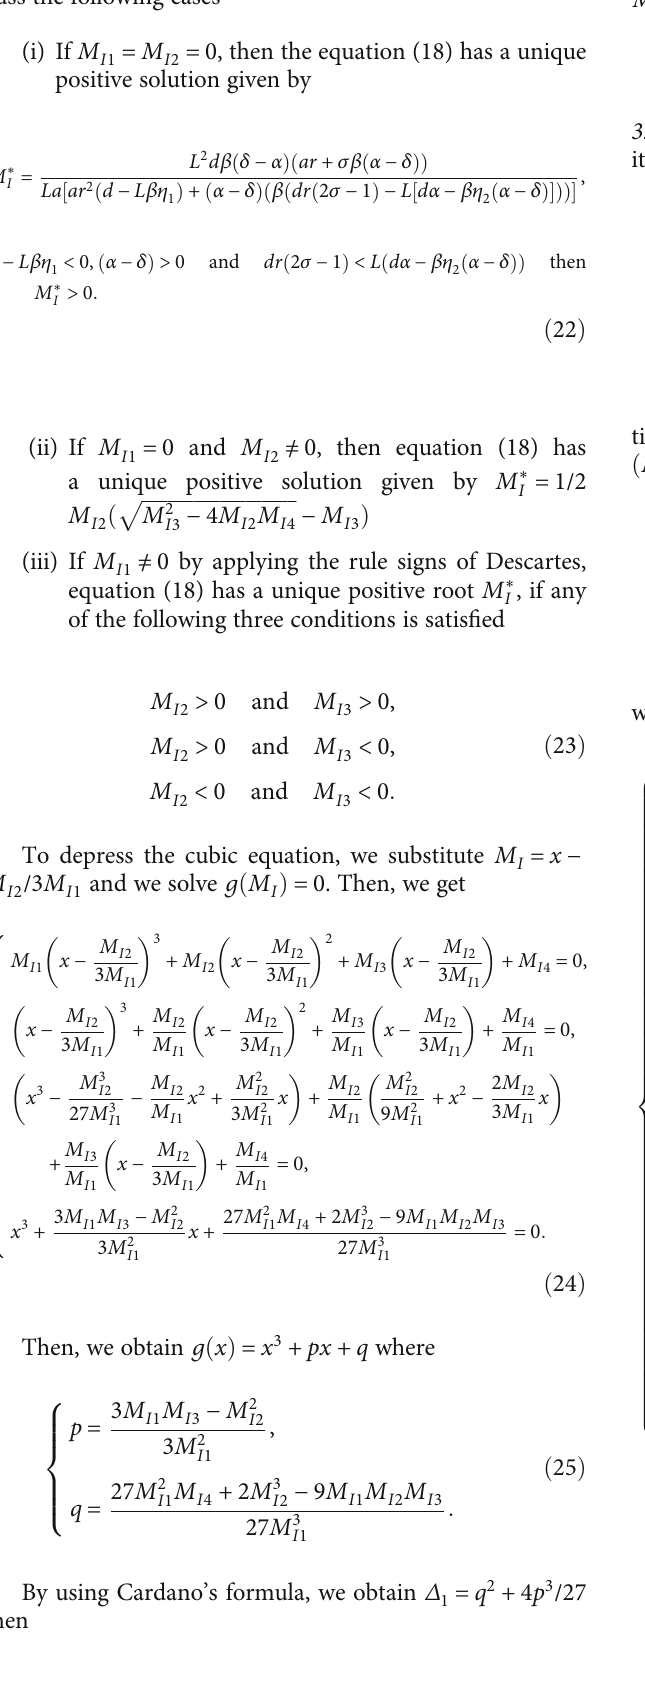
ffiffiffiffiffiffiffiffiffiffiffiffiffiffiffiffiffiffiffiffiffiffiffiffiffiffi q 2 + 4 p 3 /27